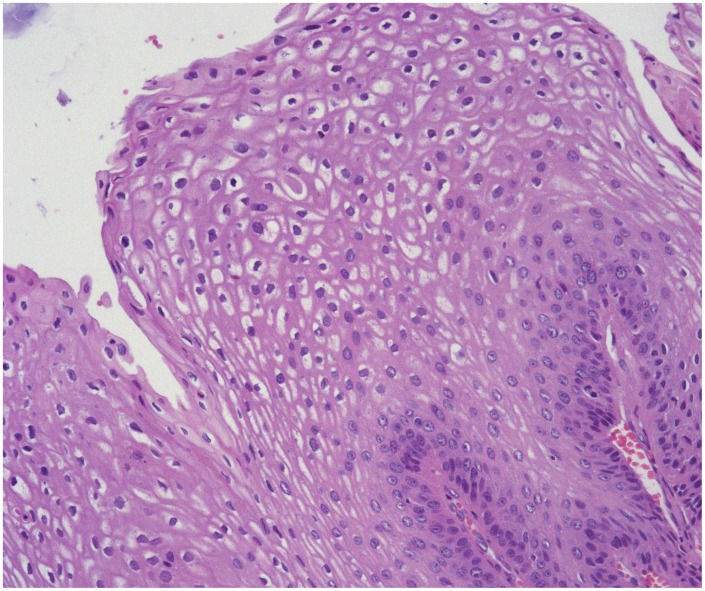
Laryngeal papilloma without atypia in a patient with adult-onset RRP (HEx20).